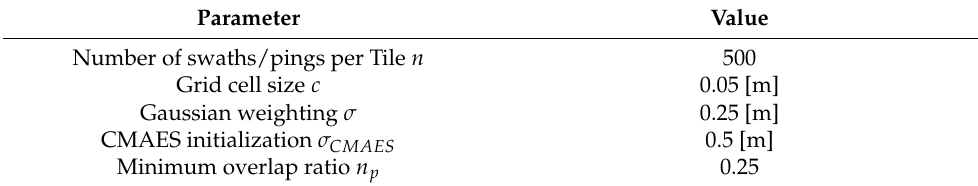
Table 2. Shared parameter settings for the vessel dataset experiment.